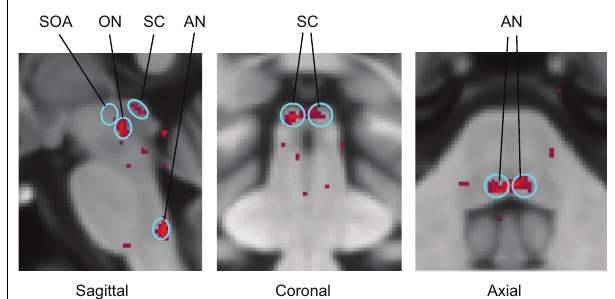
FIGURE 6 | Identification of the principal oculomotor nuclei to saccadic activation in the normal group: SOA, supra-oculomotor areas; ON, oculomotor nuclei; SC, superior colliculi; AN, abducens nuclei . All voxel activation exceeding a criterion level of p < 0.01 on the t -test is shown (red coloration) averaged across the control group after alignment with the MNI brain coordinates, against the background of the MNI152 brain anatomy (gray